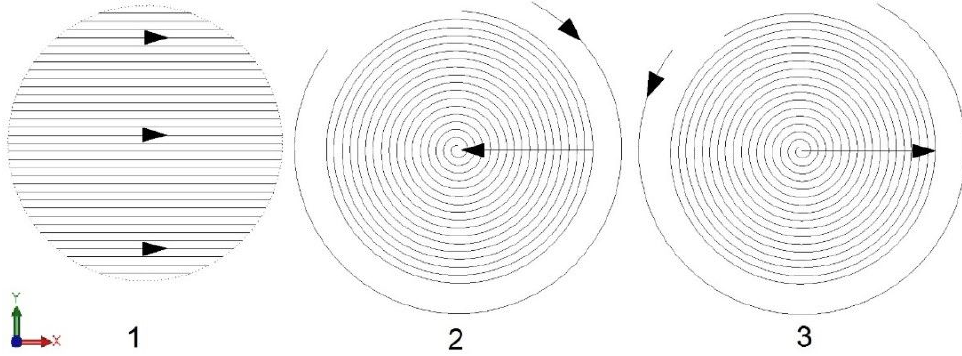
Figure 2: Graphical interpretation of prepared trajectories (1 – trajectory 1, 2 – trajectory 2 and 3 – trajectory